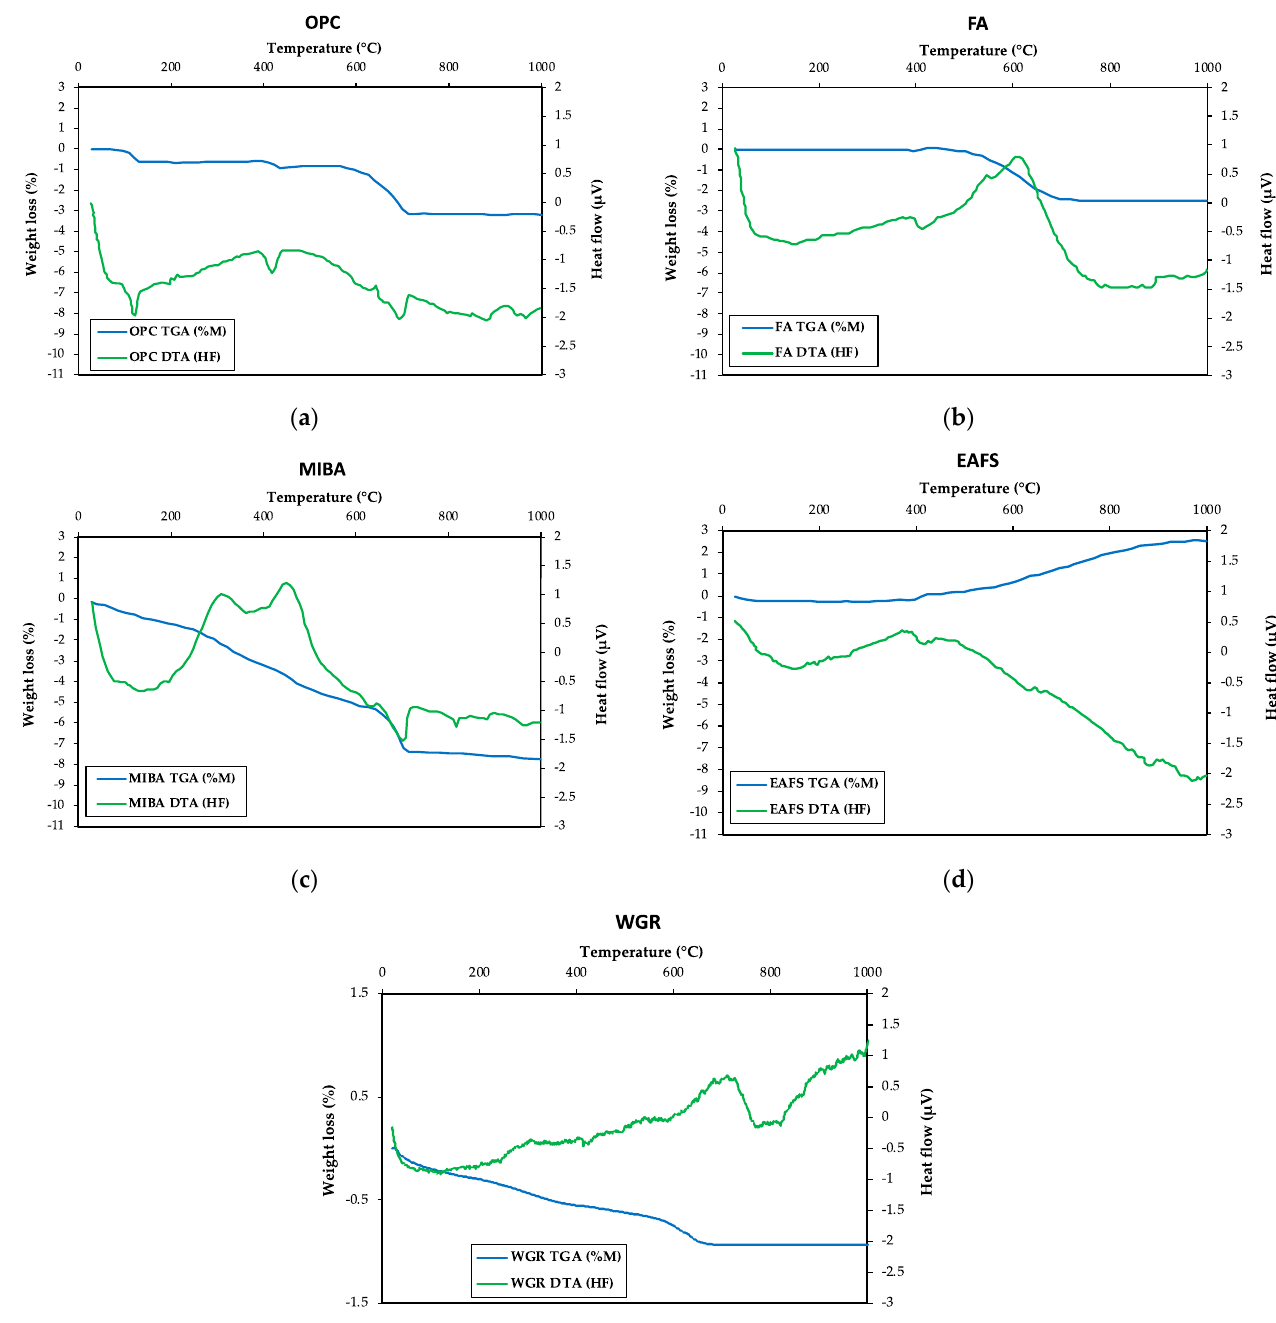
Figure 5. TGA-DTA analysis of ( a ) OPC, ( b ) FA, ( c ) MIBA, ( d ) EAFS, and ( e ) WGR (inert argon atmosphere).